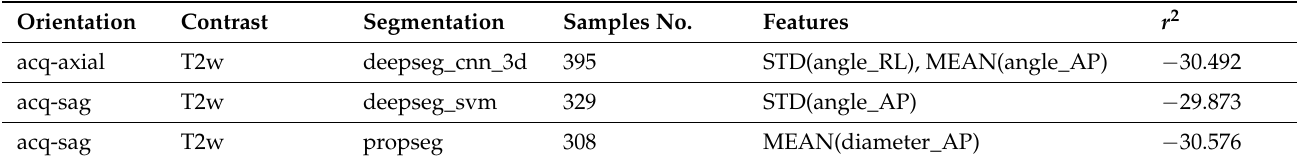
Table 4. The attributes of our linear models fit on metric data, which was standardized to a common scale, but did not become harmonized by scanner used via CovBat. Orientation, contrast, and segmentation represent the acquisition methodology associated with the model. Features contains the list of features used to train the model, as selected by SciKit-Learn’s SelectFdr function.